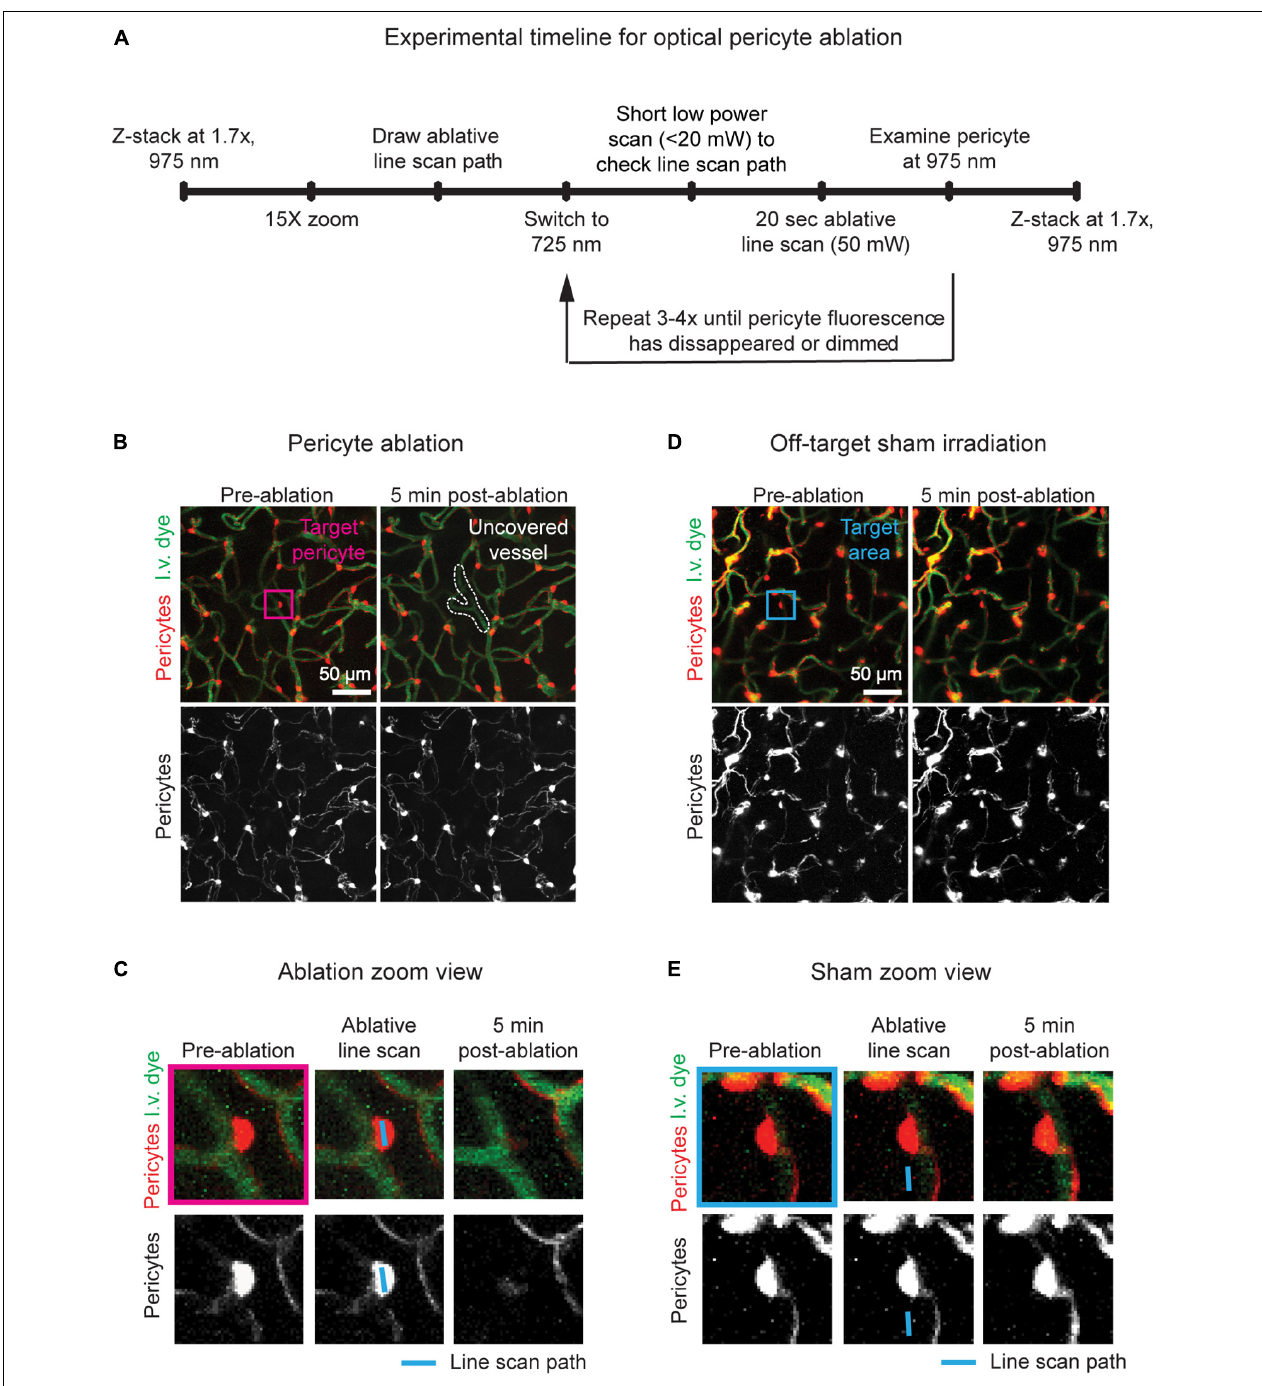
FIGURE 2 | Timeline and examples of optical pericyte ablation and sham irradiation. (A) Procedural timeline to ablate single pericytes or perform sham irradiations. (B) Example of an on-target optical pericyte ablation. The area is shown before and 5 min after ablation. Pericytes are shown in red, and vessels are shown in green. The pericyte targeted for ablation is centered in the fuchsia box. Following ablation, the uncovered vessel area is outlined in white. (C) Zoomed in images of the pericyte of interest (fuchsia box in C ) before ablation, with the line scan path overlayed, and 5 min after ablation. Scale bar = 10 µ m. (D) Example of an off-target sham irradiation. The area is shown before and 5 min after irradiation. Pericytes are shown in red, and vessels are shown in green. The area targeted for sham irradiation is centered in the blue box. (E) Zoomed in images of the area of interest (blue box in D ) before sham irradiation, with the line scan path overlayed, and 5 min after sham irradiation. Scale bar = 10 µ